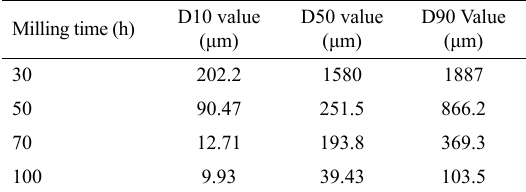
It can be seen in Table 2 the “D” values refering to D10, D50, and D90 of the aluminum bronze powders in function of milling time. Table 2. Aluminum bronze powders “D” values.